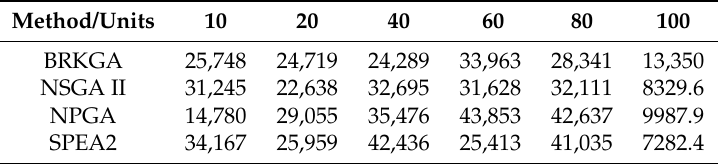
Table 13. Spacing average measures over 10 optimization